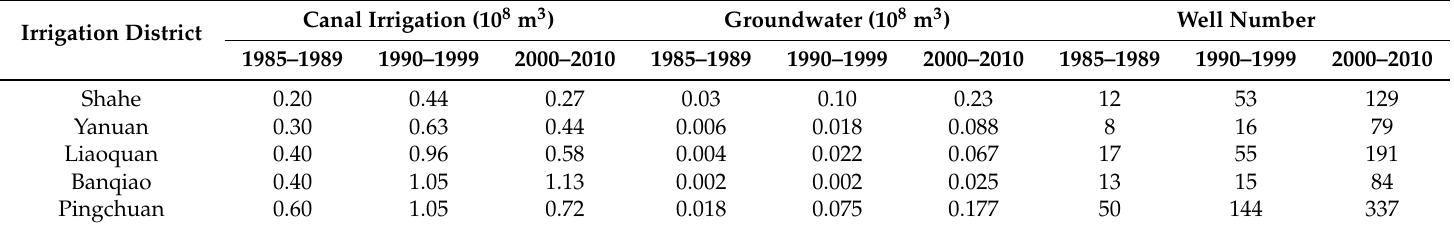
Table 1. The temporal series proportions of water resources between surface water irrigation and groundwater exploitation for each irrigation districts in three